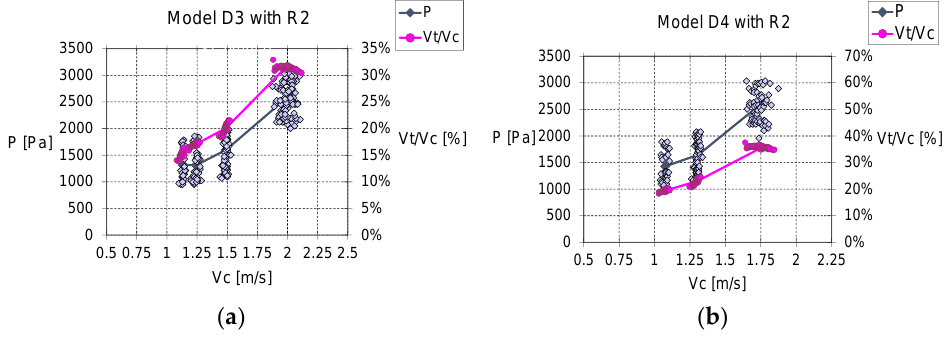
Figure 20. Characteristics 𝑃 and 𝑉 𝑡 /𝑉 𝑐 with resistance R2, for models D3 ( a ) and D4 ( b ).